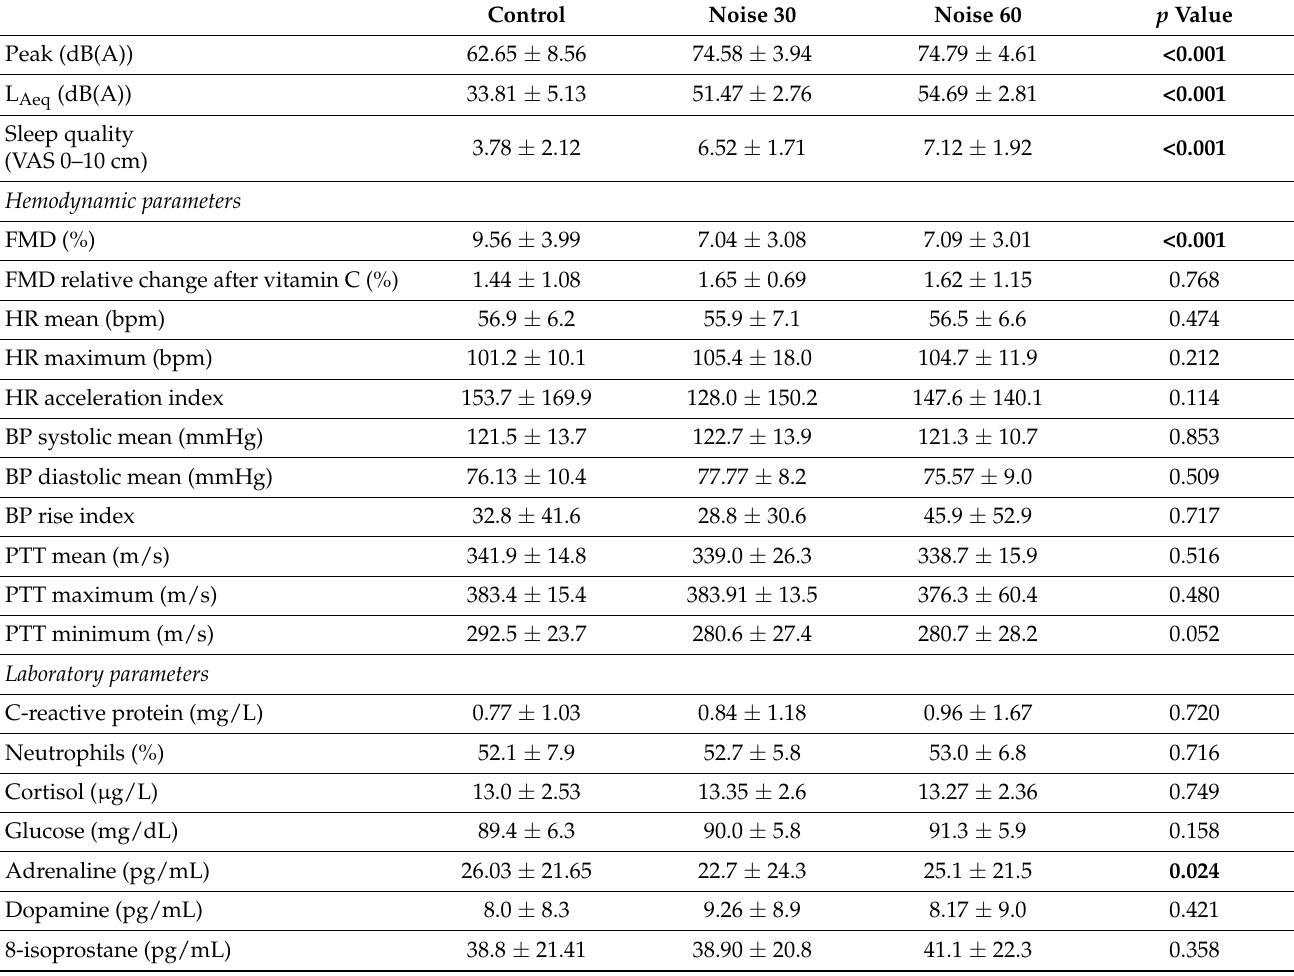
Table 3. Effects of nocturnal train noise on sleep quality, hemodynamic, and laboratory parameters in men ( n =